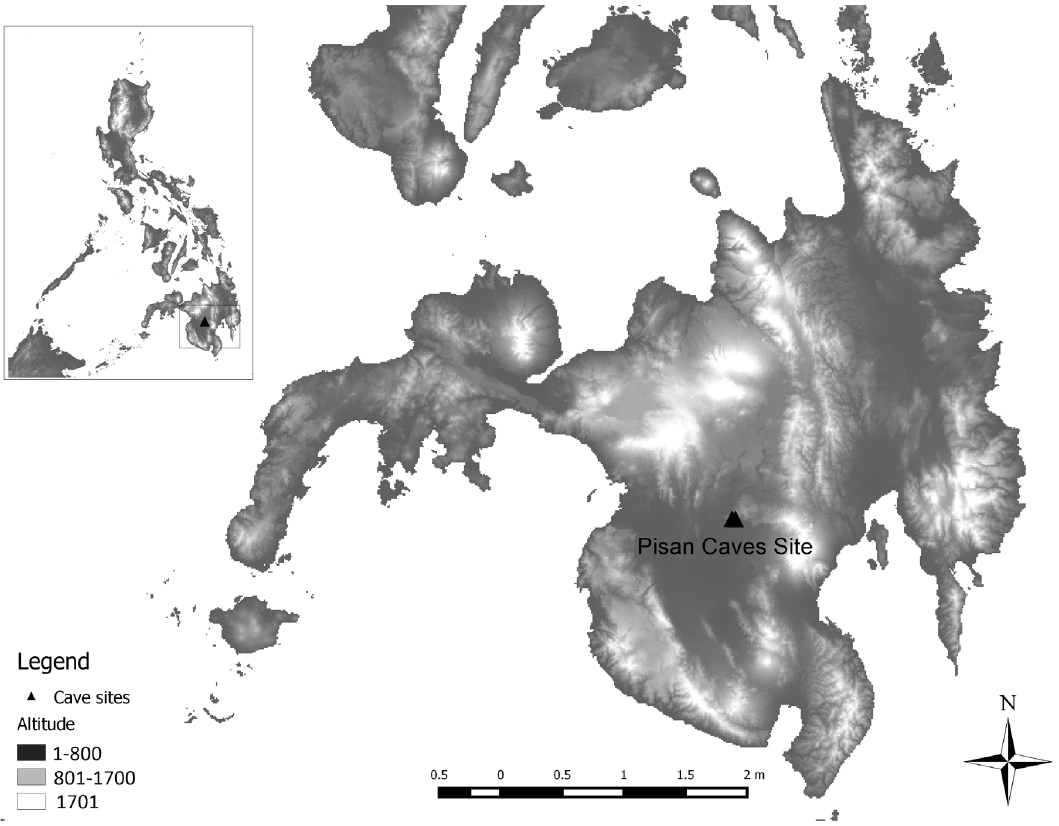
Figure 1. Location of the Pisan caves, in South central Mindanao, Philippines (Quantum GIS 2.2.0 version). All caves are found in different area but in a single